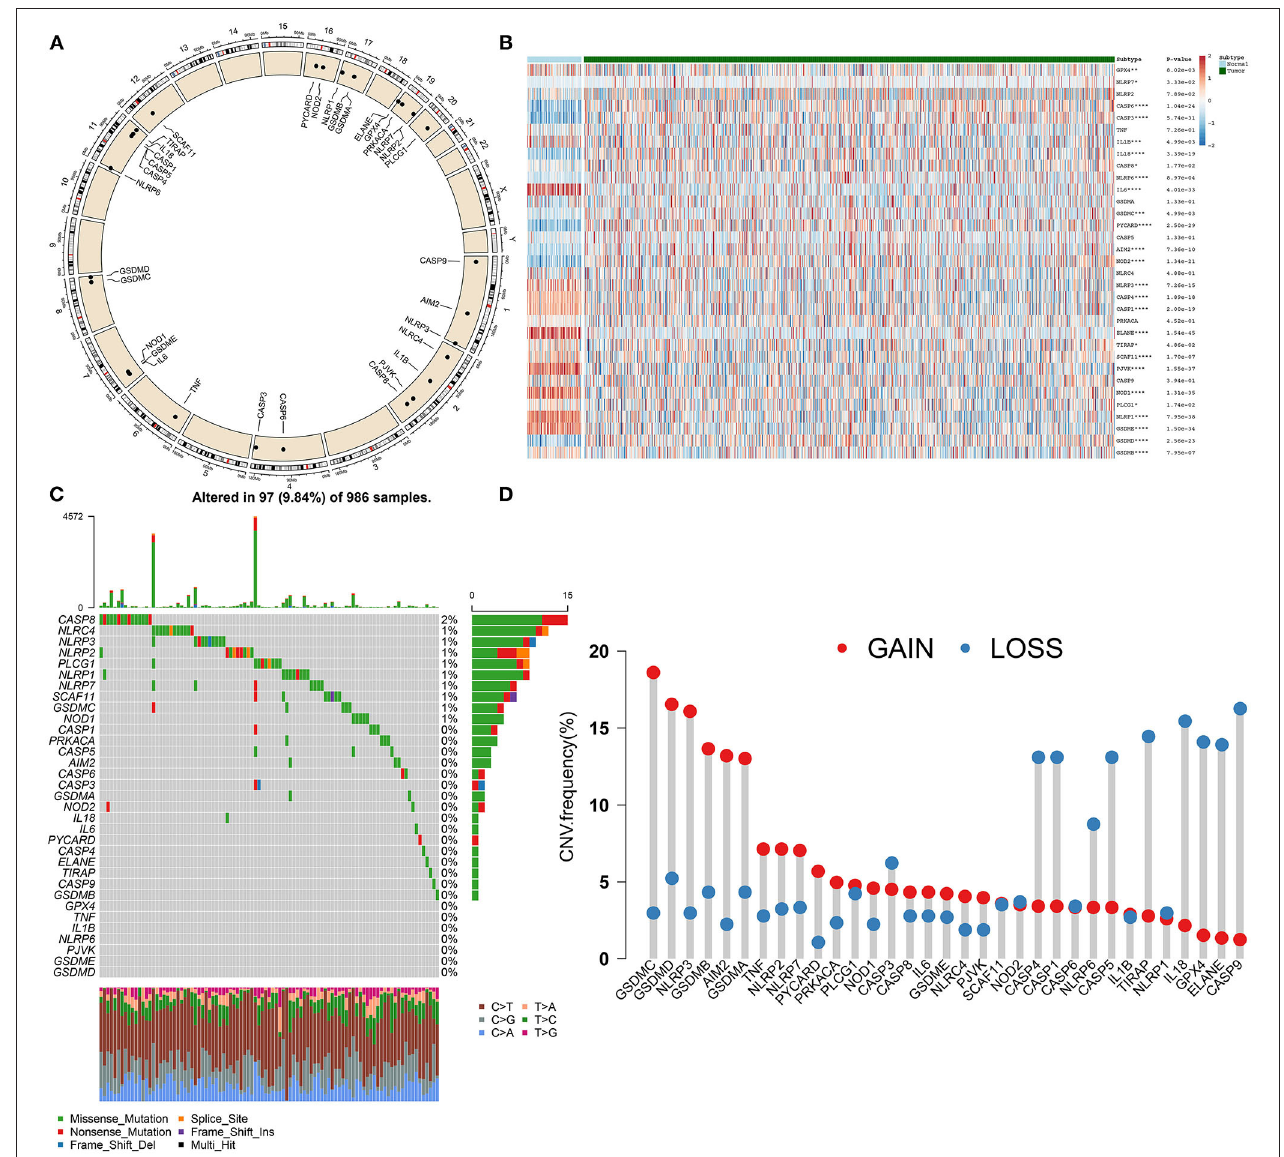
FIGURE 1 | Landscape of expression and genetic mutations of pyroptosis-related genes in breast cancer. (A) Circus plots of chromosome distributions of pyroptosis-related genes. (B) Heatmap of expression patterns of pyroptosis-related genes in normal and breast cancer tissues. * p < 0.05; ** p < 0.01; *** p < 0.001; **** p < 0.0001 . (C) Waterfall chart of somatic mutations of pyroptosis-related genes. (D) Frequencies of gain and loss for pyroptosis-related